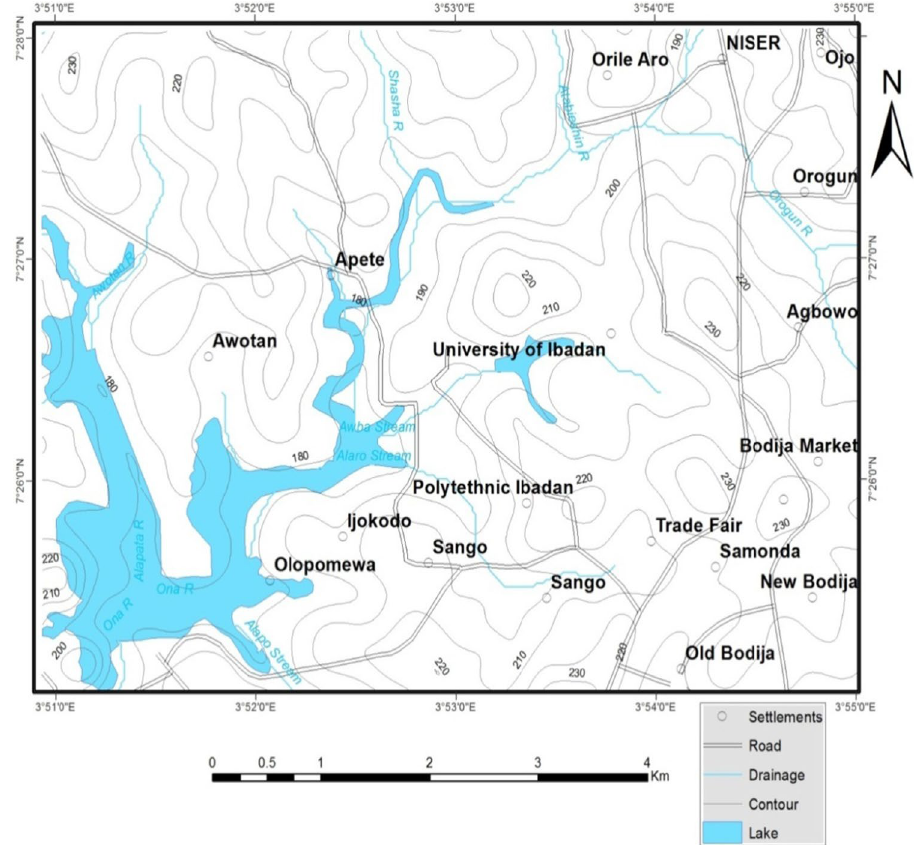
Fig. 1 Location and topographic map of the study